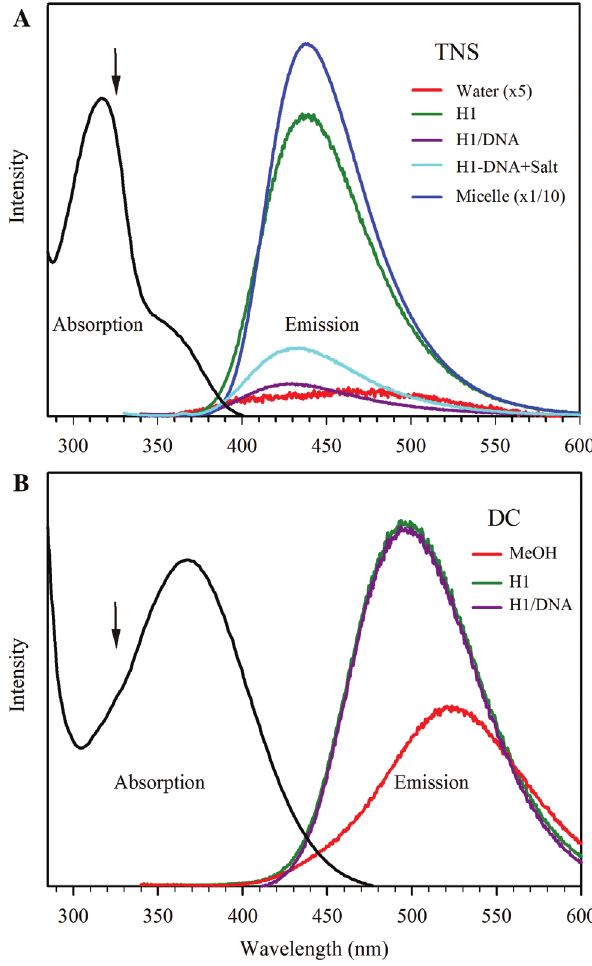
Figure 4 The steady-state fluorescence spectra of the probes (A) TNS and (B) DC in chemical and biological environments studied with the same probe